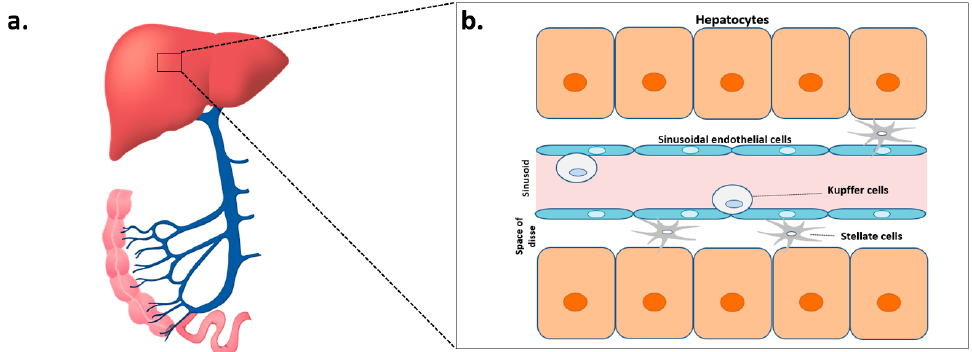
Figure 1. The architecture of the liver. ( a ) Representation of the hepatic portal system, showing the intestines (in pink), the portal vein (in blue), and the liver (red). ( b ) Representation of the main cell types in the liver: hepatocytes, sinusoidal endothelial cells, Kupffer cells, and stellate cells.